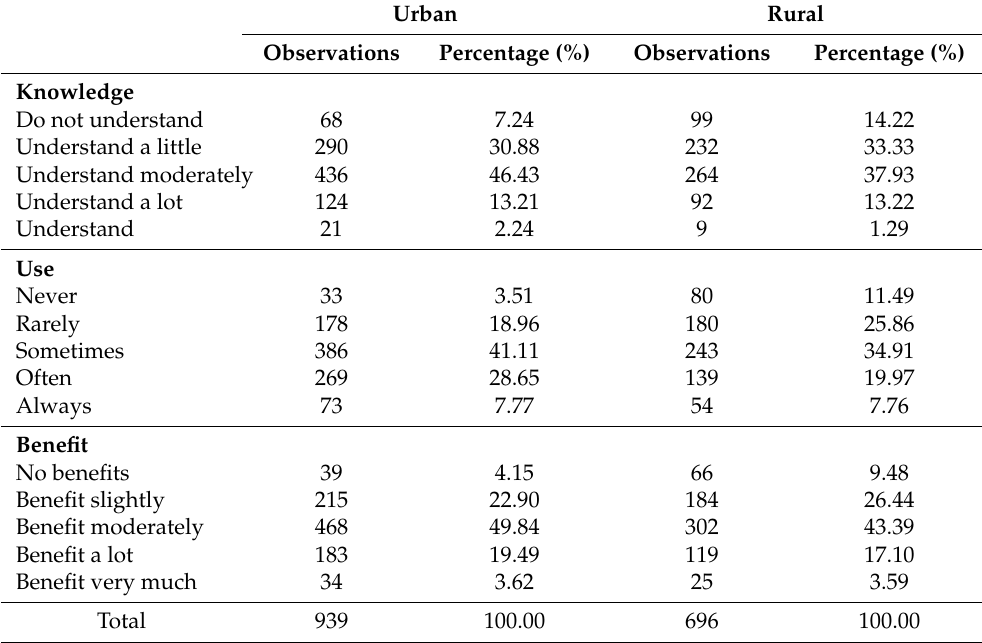
Table 2. The knowledge, use and perceived benefits of nutrition labels among rural and urban